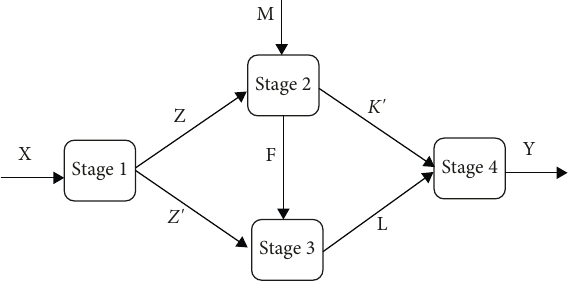
Figure 3: The proposed network